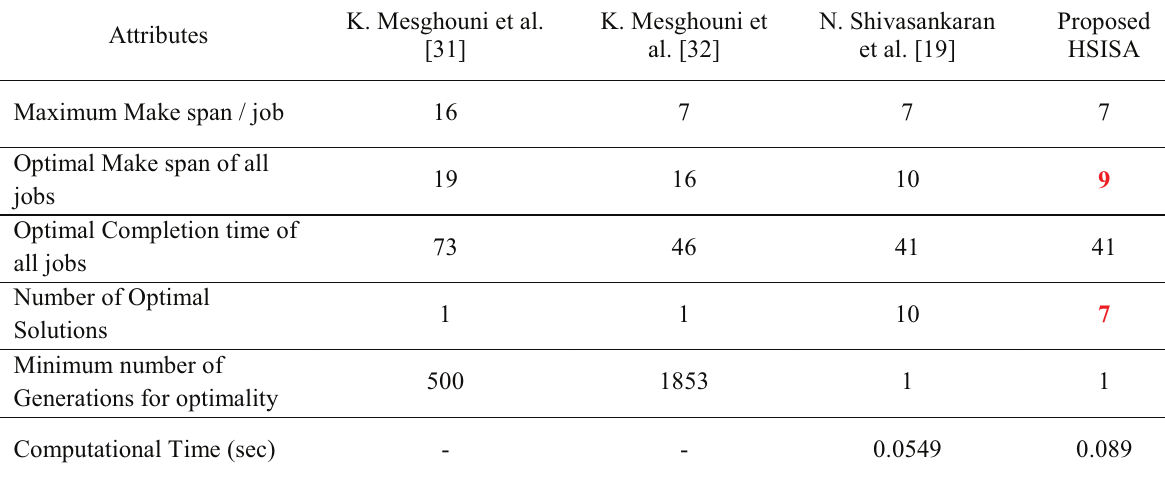
Table 02 Results of Mesghouni